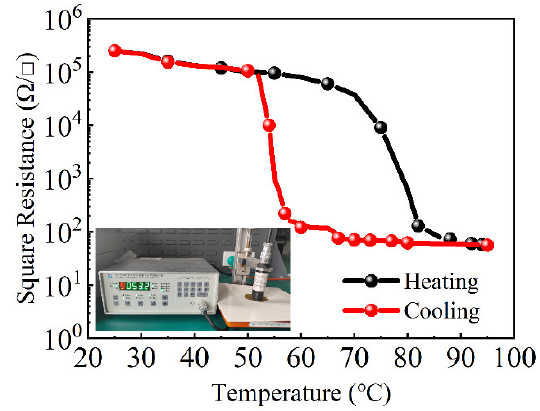
Figure 6. The square resistance of VO 2 and the test environment.